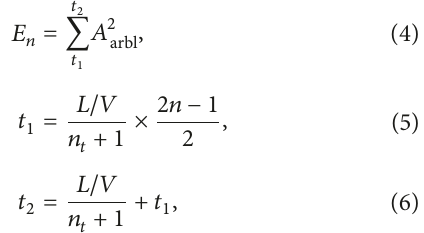
straight line. Additionally, to check the effect of changes in velocity on the damage detection, three different speeds were considered (0.3, 0.4, and 0.5 m/s). The sampling frequency of the acceleration signal was 500